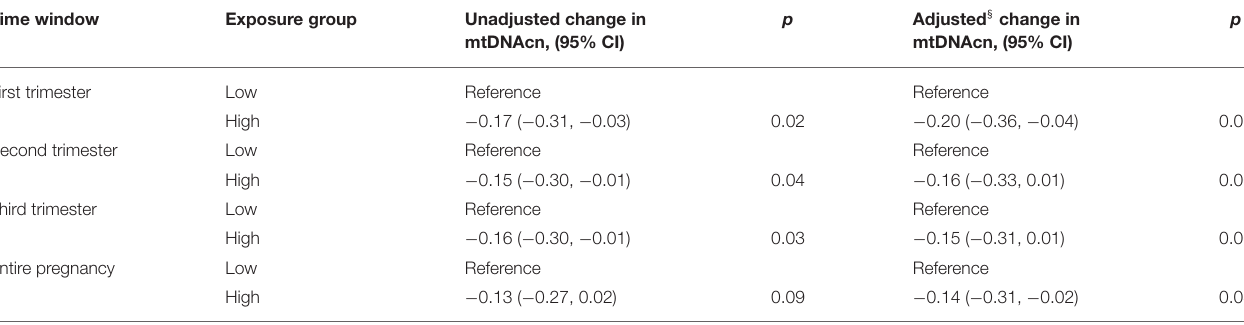
TABLE 4 | Linear regression analysis of placental relative mtDNAcn in women with high NO x exposure as compared with women with low NO x exposure (median cut-off).